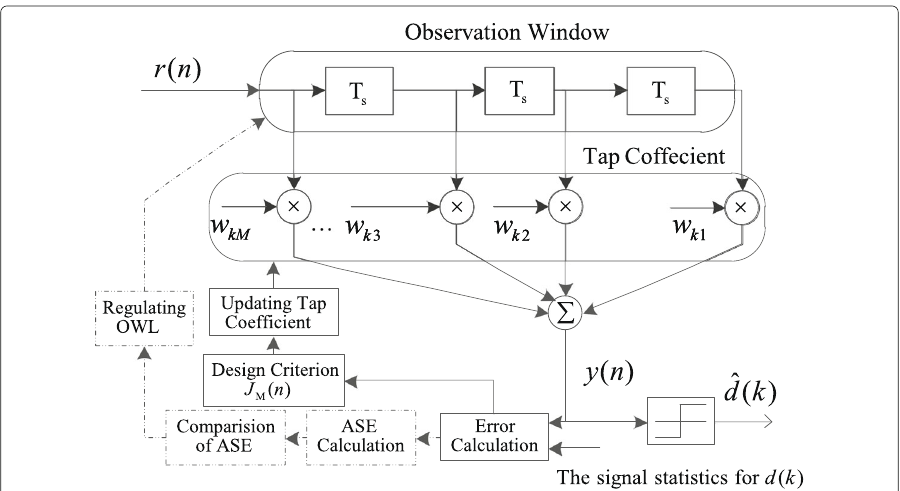
Fig. 1 The structure of VOWL-BED (the solid line denotes